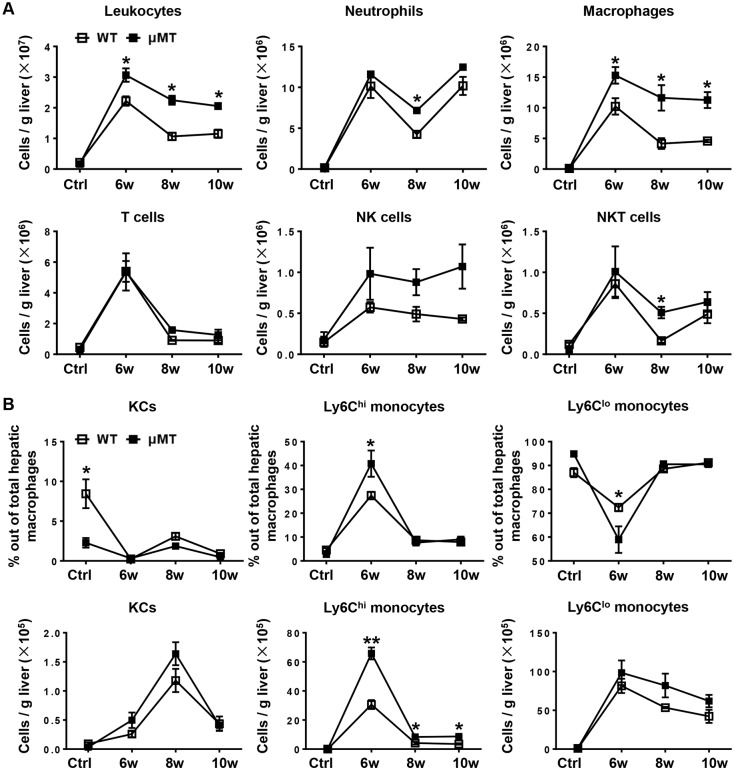
B cell deficiency results in increased number of macrophages in the liver.(A) The infiltration of hepatic leukocytes (CD45+), macrophages (CD45+CD11b+F4/80+), neutrophils (CD45+CD11b+Ly6G+), T cells (CD45+CD3+NK1.1−), NK cells (CD45+CD3−NK1.1+), and NKT cells (CD45+CD3+NK1.1+) after infection were quantified by flow cytometric analysis. Controls (Ctrl) were uninfected mice. (B) Graphical summary showing percentages of KCs (CD11bloF4/80hi), Ly6Chi monocytes (CD11bhiF4/80loly6Chi), and Ly6Clo monocytes (CD11bhiF4/80loly6Clo) out of total hepatic macrophages (CD45+CD11b+F4/80+). (C) Absolute numbers of KCs, Ly6Chi monocytes, and Ly6Clo monocytes in WT mice and μMT mice. Data represent mean ± SD; n = 8–10 mice per time point from two independent experiments. *p < 0.05, **p < 0.01, versus WT mice.